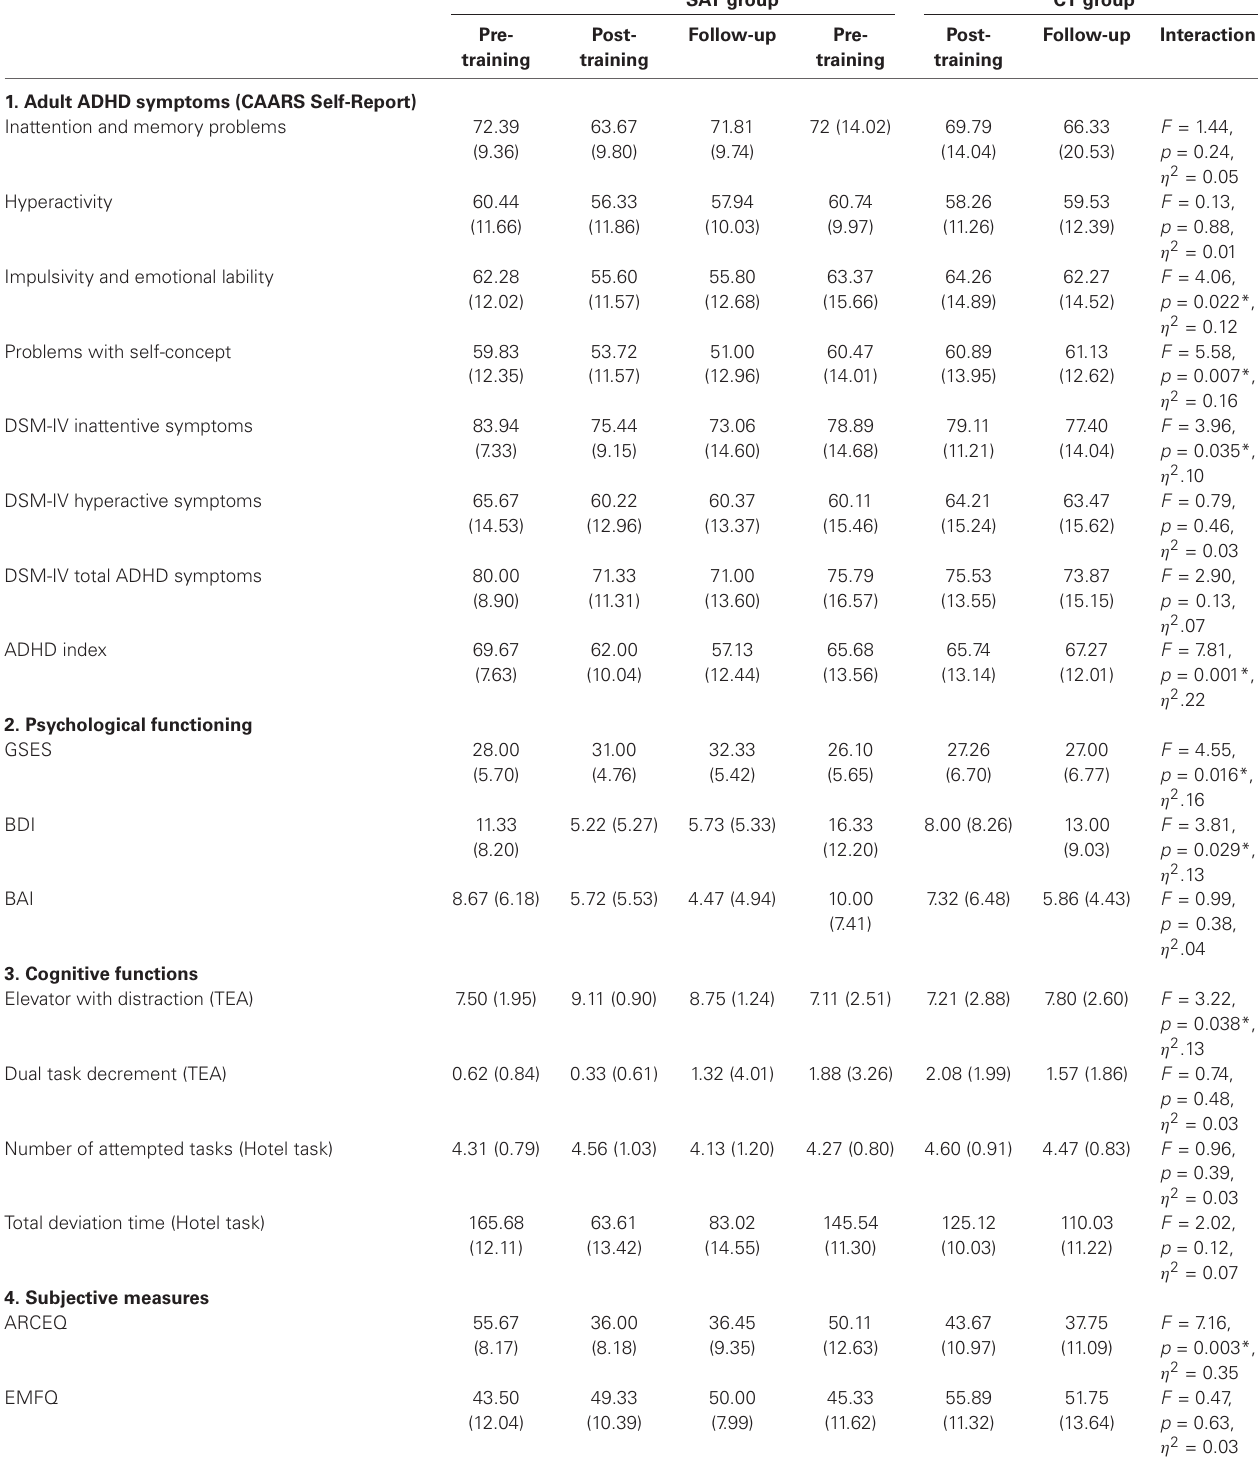
Table 2 | Mean scores (and Standard Deviations) on ADHD symptom measures, social functioning and psychiatric comorbidities’ scales, neuropsychological tests and subjective attention and memory ratings for the SAT group and CT group, results of the ANCOVAs and between group effect sizes